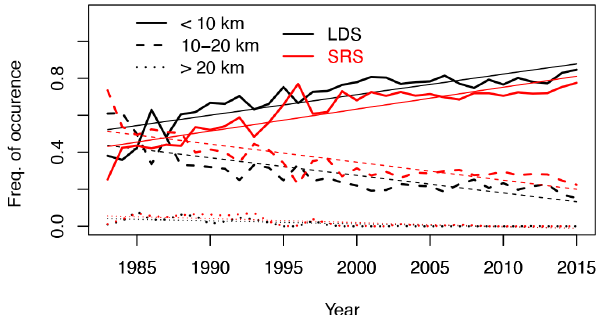
Figure 8. Time series of horizontal visibility. Time series from 1983–2015 and simple linear-regression lines show the temporal evolution of the frequency of horizontal-visibility observations for the three categories “below 10km” (solid), “between 10 and 20km” (dashed), and “above 20km” (dotted). Data are shown for the LDS (black) and the SRS (red) and are spatially averaged over all avail- able stations (see Fig.